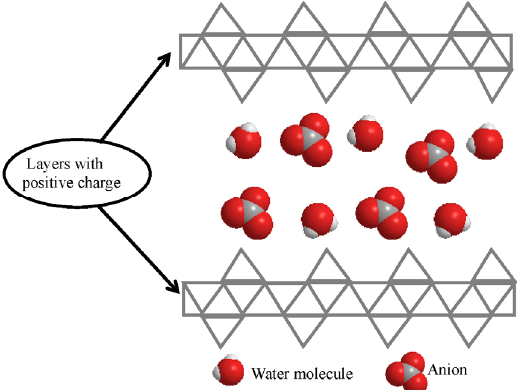
Figure 1. Structure of Layered